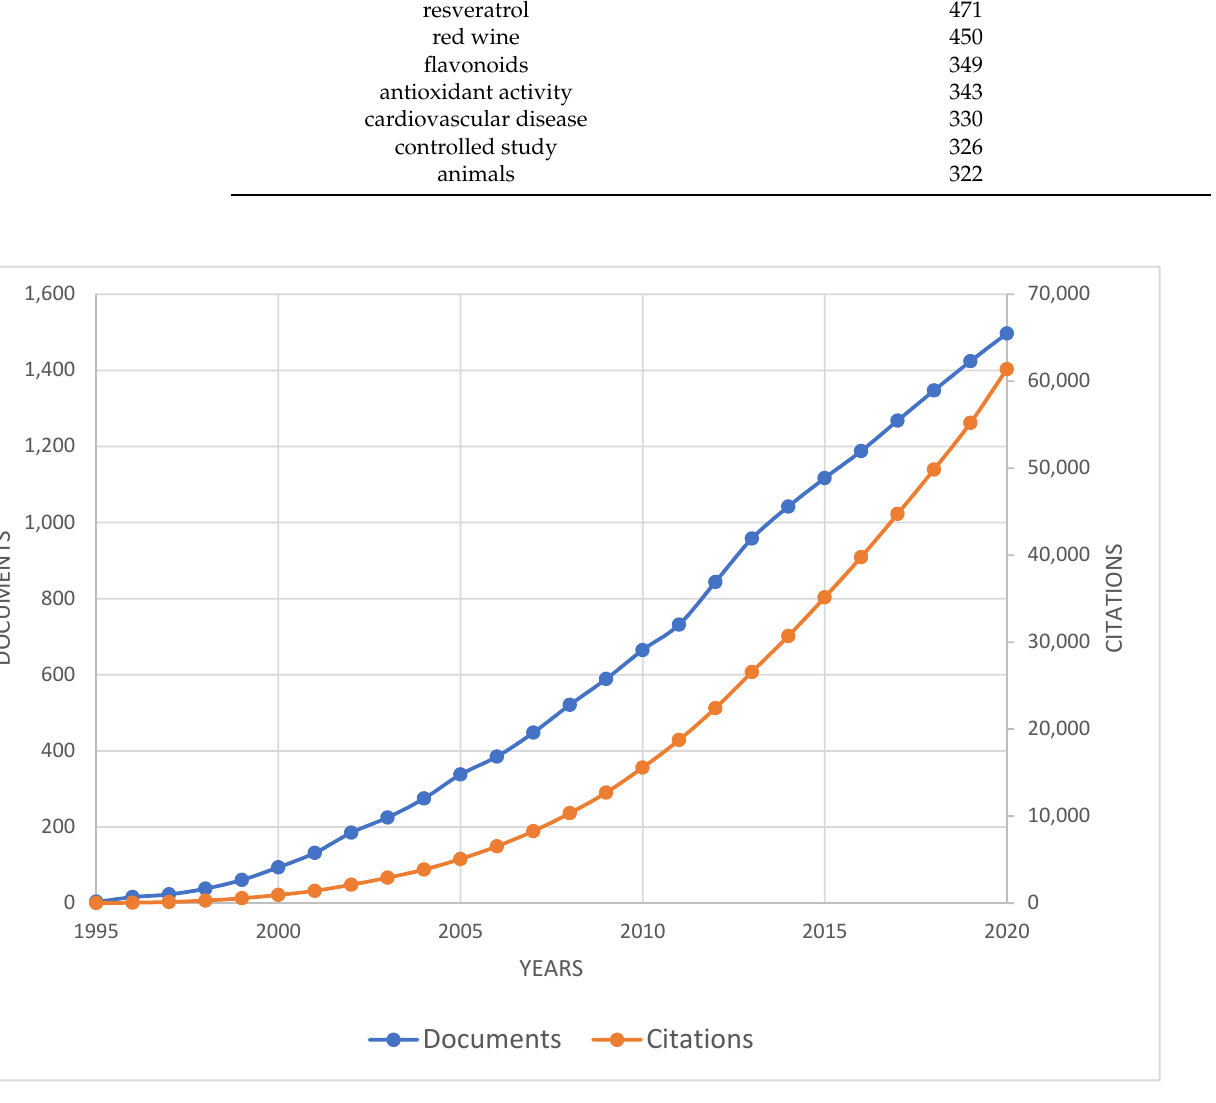
Figure 2. Publication and citation trends of the relationships between wine polyphenols and health research displayed as cumulative function. (Bibliometric data were extracted from the Scopus online database).